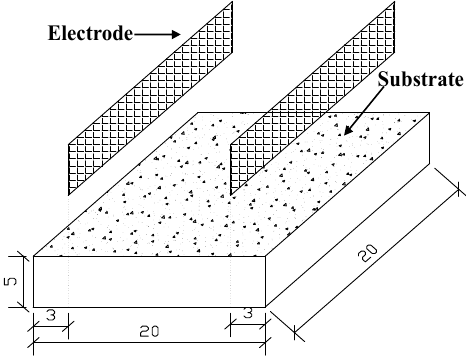
Figure 2. Stereogram of substrate for electric heating test (unit: cm).